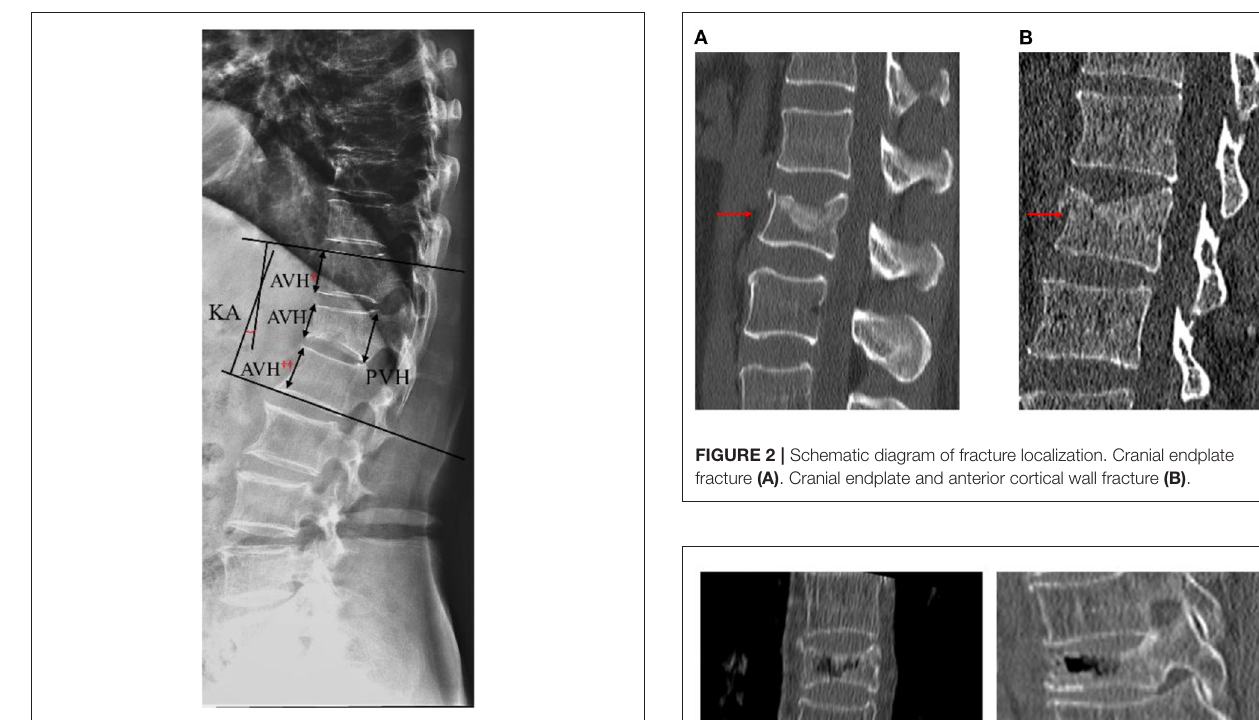
FIGURE 1 | Schematic diagram of vertebral height loss and local kyphotic angle (KA). Vertebral body compression rate (VBCR) = anterior vertebral height (AVH)/posterior vertebral height (PVH) × 100%; percentage of anterior height compression (PAHC) = AVH/[(AVH † + AVH †† )/2] × 100%.